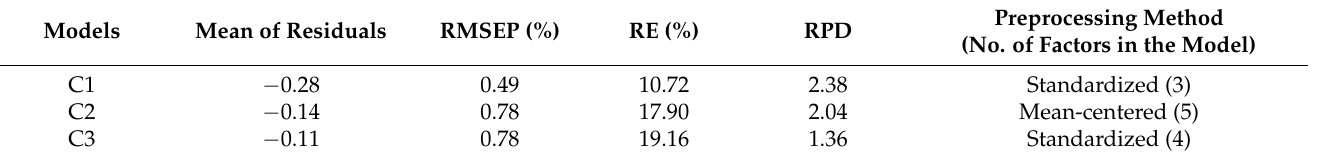
Table 2. Results of the prediction of Rx SiO 2 with the models for each